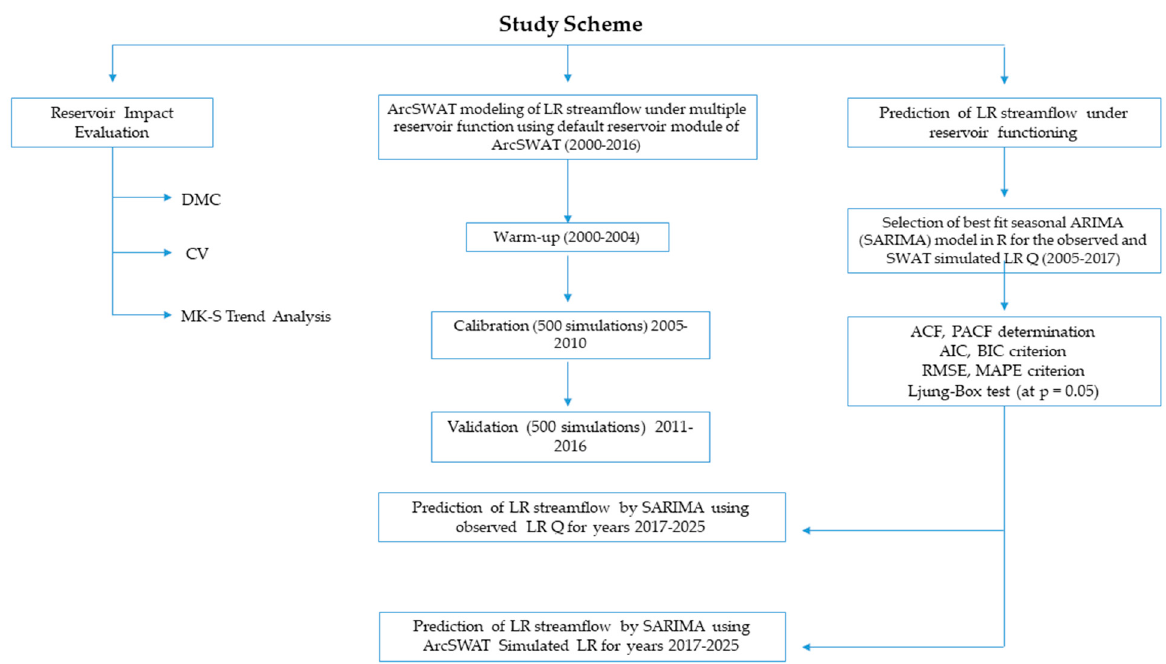
Figure 2. Schematic representation of reservoir impact evaluation, seasonal AutoRegressive Integrated Moving Average (SARIMA) and Soil and Water Assessment Tool (SWAT) model setup for the current study. LR: Lhasa River; DMC: double-mass curve; MK-S: non-parametric Mann–Kendall test; CV: coefficient of variability; PACF: partial autocorrelation function; AIC: Akaike’s information criterion; BIC: Bayesian information criterion; RMSE: root mean square error; MAPE: mean absolute percentage error; Q: Discharge (m 3 /s).